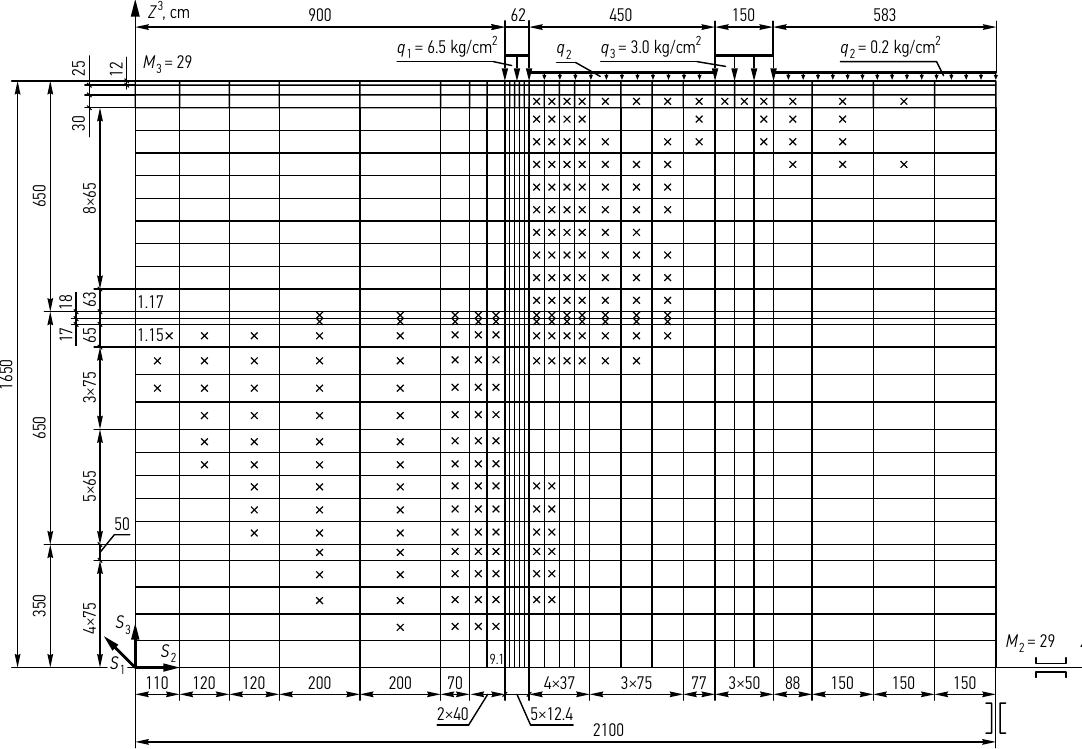
Fig. 3. The design interaction scheme of the overpass strengthening fencing structures with the soil semispace and the scheme of plastic deformations